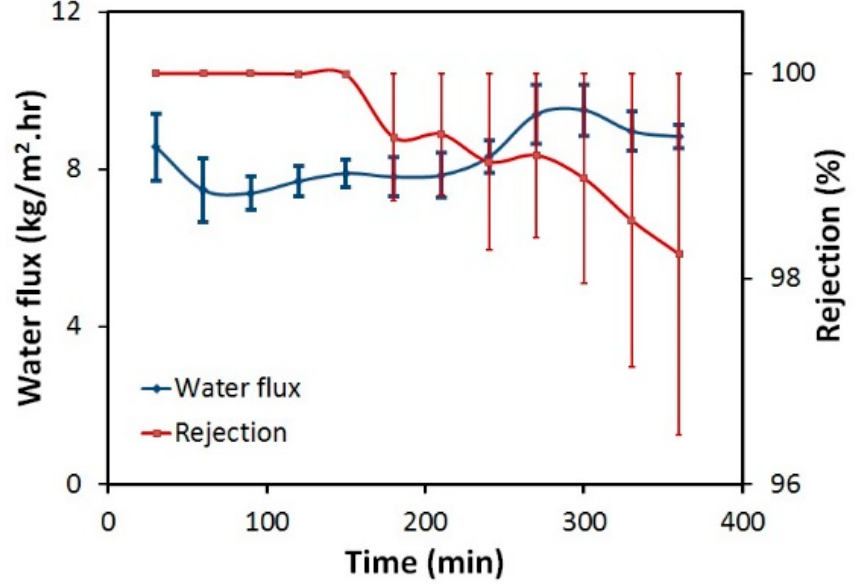
Figure 6. DCMD water flux and rejection for Dual-layer PES-PVDF membrane. Experimental Figure6. DCMDwaterfluxandrejectionforDual-layerPES-PVDFmembrane.